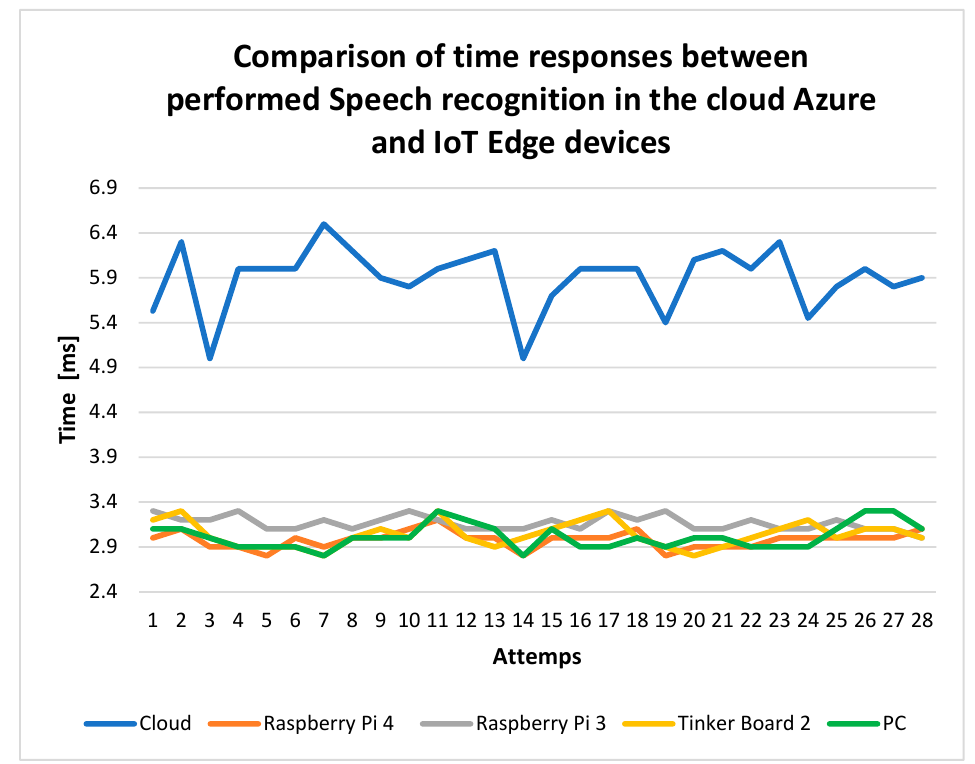
Figure 14. Comparison of time responses between performed speech recognition in the cloud Azure and IoT edge devices.